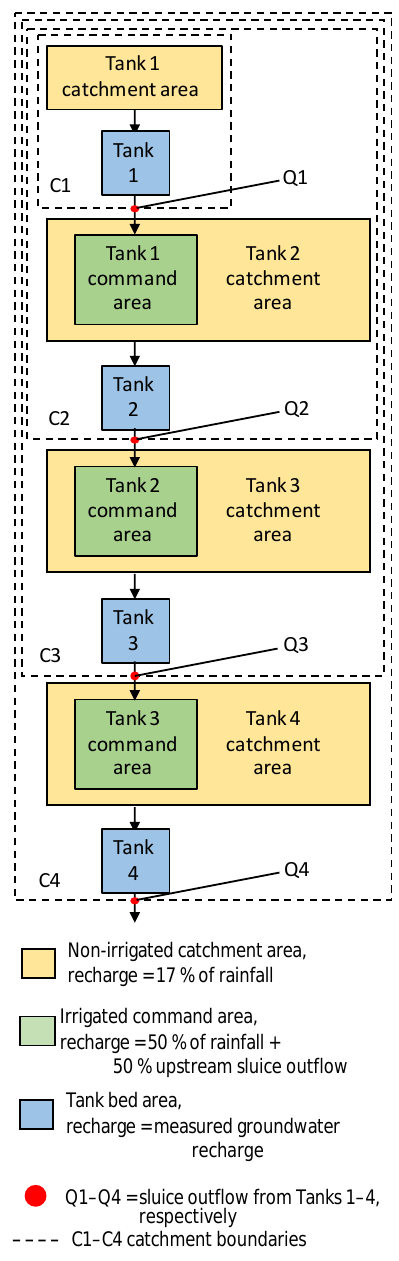
Figure 4. Schematic for the catchment-scale water balance calcula- tions. The dotted lines represent the boundaries, and points Q1–Q4 represent the outlet points for the four nested catchments